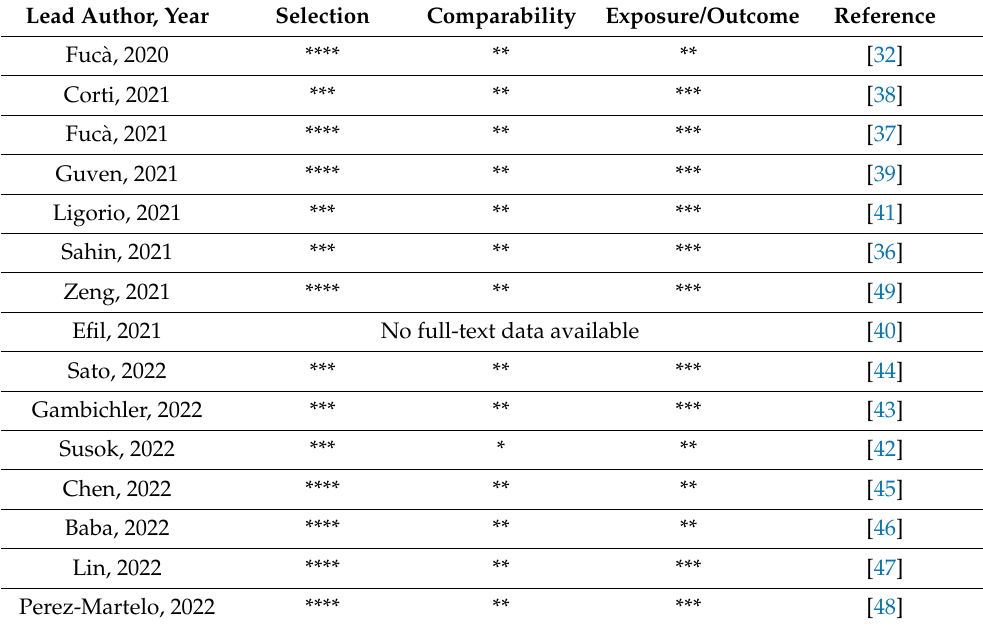
Table 2. Newcastle-Ottawa scores of included studies (Note: A star system was used for allow a semi quantitative assessment of study quality. A study was awarded a maximum of four stars for the selection and three stars for exposure/outcome categories. A maximum of two stars were awarded for comparability).